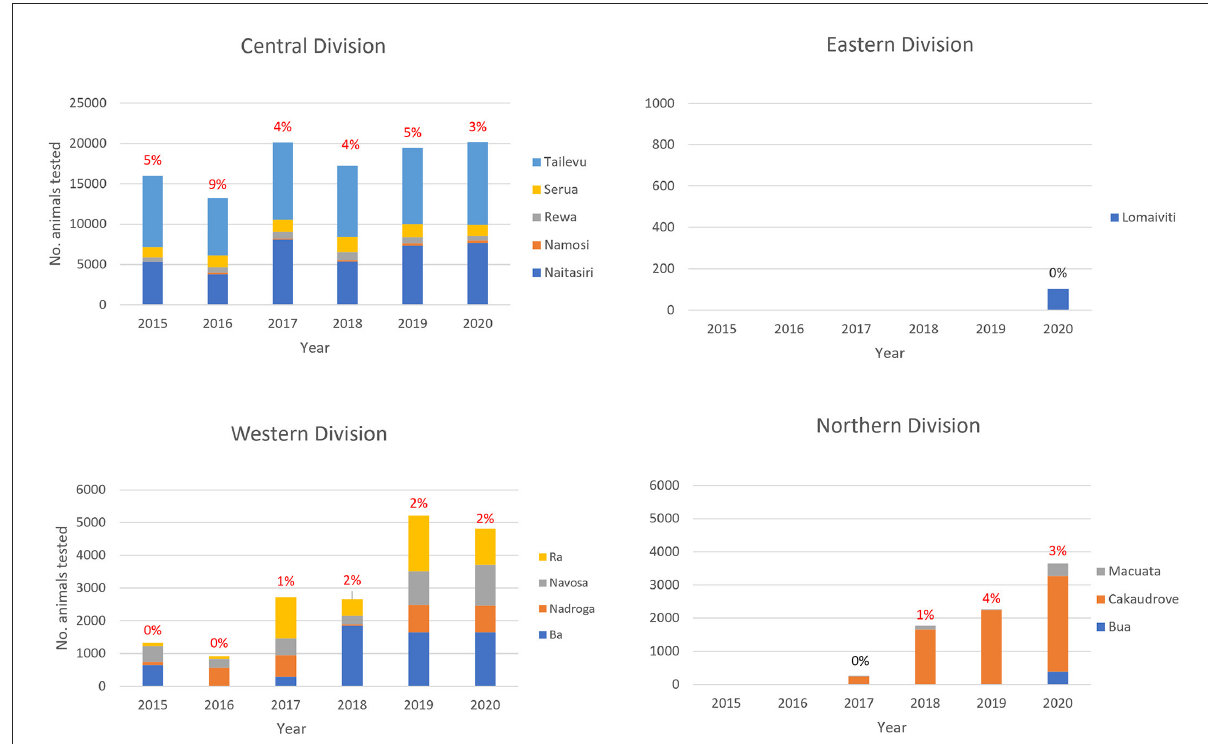
FIGURE3 Total number of unique identity cattle tested each year by division and province in the Fiji BTEC program from 2015 to 2020. The percentage positive for bovine tuberculosis is shown above each bar.